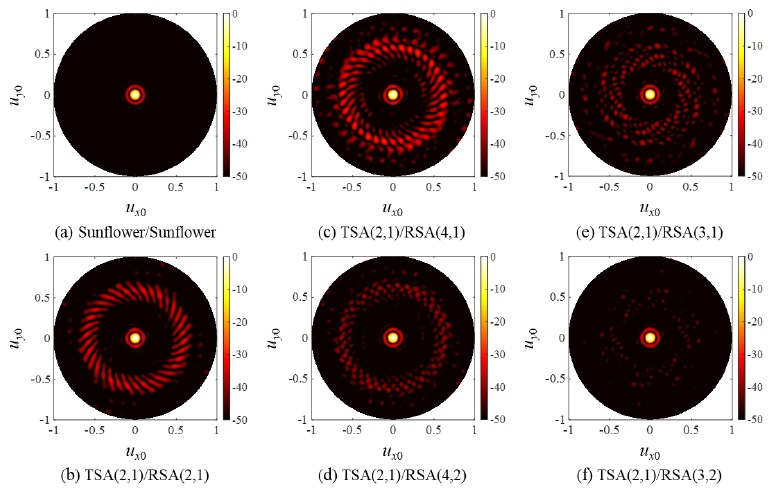
Figure 13. Two-way, CW PSFs of ( a ) the sunflower array pair and ( b – f ) the SSA pairs.